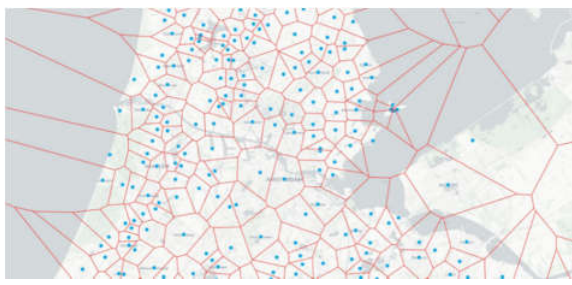
Figure 2 . Division of the Netherlands by the Voronoi polygons generated around the cities.